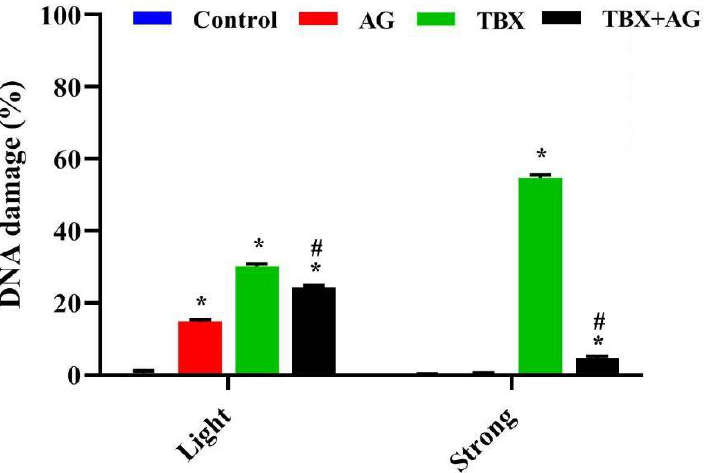
Figure 8. The protective effect of AG against TBX-induced DNA strand breaks in isolated periph- eral blood leucocytes of treated rats after 24 h of treatments. *: Significant ( p < 0.001) relative to untreated groups. #: Significant ( p < 0.001) relative to TBX-treated groups. Data were represented as mean ± SE of three independent experiments ( n = 5). AG: 10% Arabic gum, TBX: Telebrix (1600 mg I/kg b.wt.) and TBX+AG: co-treatment with 1600 mg/kg b.wt. and 10% Arabic gum.